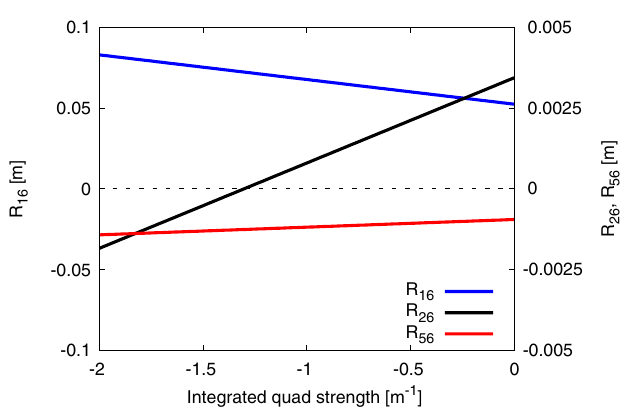
FIG. 2. Dispersion terms R 16 ; FODO , R 26 ; FODO , and R 56 ; FODO of one FODO arc cell, versus the integrated strength of the defo- cusing quadrupole K 1 d .